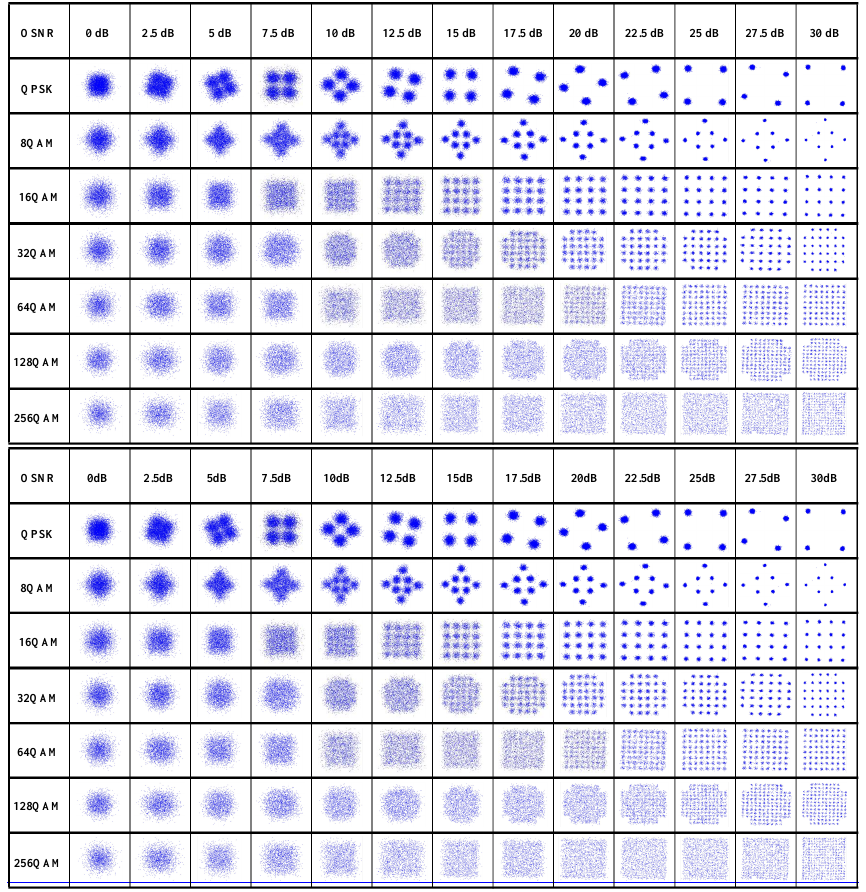
Figure 4. The sample constellation diagram obtained after 80 km SMF transmission. Seven modulation signal samples are used in the test set for the simulation test, according to the proposed MFI scheme. As shown in Figures 5 and 6, the overall and average identification accuracy at low OSNR are plotted in the 3D histograms for the seven signals transmitted through 80 km and 120 km fiber, respectively.